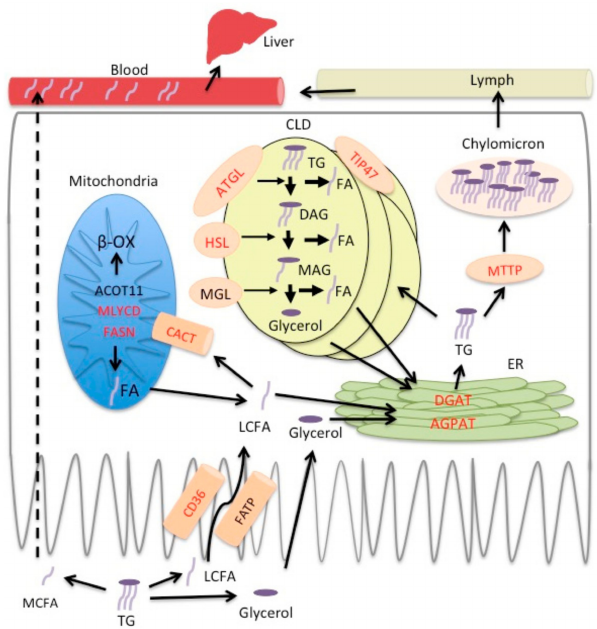
Figure 4. Model of lipid processing regulation by PPAR γ in enterocytes. Red font indicates genes whose upregulation is lost or expression is reduced in enterocytes of iePPAR γ KO mice after canola oil gavage. Following intestinal digestion, FAs and glycerol are absorbed by enterocytes. Medium chain FAs (MCFA) travel through the enterocyte directly to blood (portal vein) (dashed arrow) and are transported to the liver as free FAs. Long chain FAs (LCFAs) are taken up by the enterocytes with the assistance of transporter proteins (CD36 and FATP). FAs are trafficked to mitochondria, where they are catabolized, or to the endoplasmic reticulum (ER), where there serve as substrates for TG assembly. Depending on the lipid load, TGs can be temporarily stored in cytoplasmic lipid droplets (CLD) or incorporated into chylomicrons and secreted into the